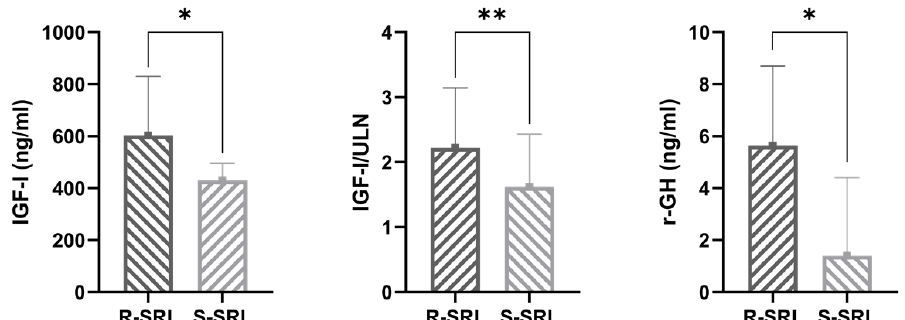
Figure 4. Median values of biochemical disease control parameters three months after surgery in patients resistant (R-SRL) and in those responsive to somatostatin receptor ligands (S-SRL) (* p < 0.01, ** p = 0.02).